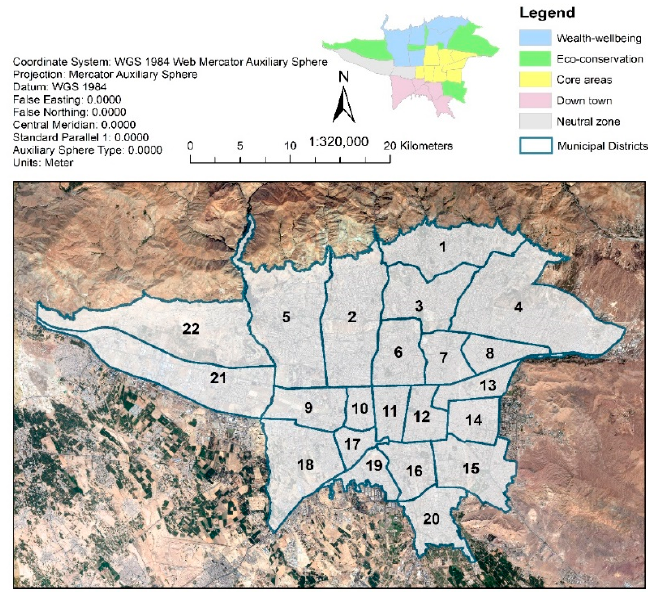
Figure 2. Municipal districts in Tehran.